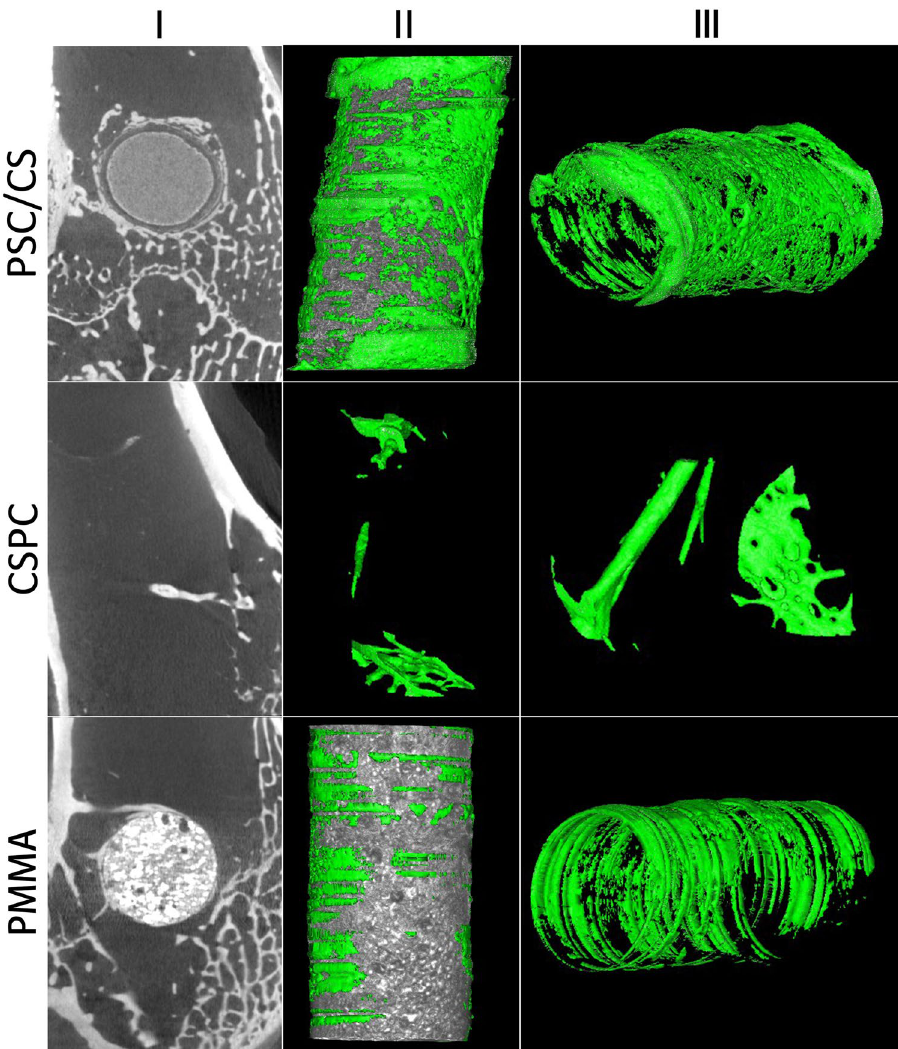
Figure 4. Sagittal images (column I) and 3D reconstructed images (column II and III) by micro-CT imaging of the area surrounding the cement implants after 12 weeks. The green part represents newly formed bone, and the gray part represents residual cement.